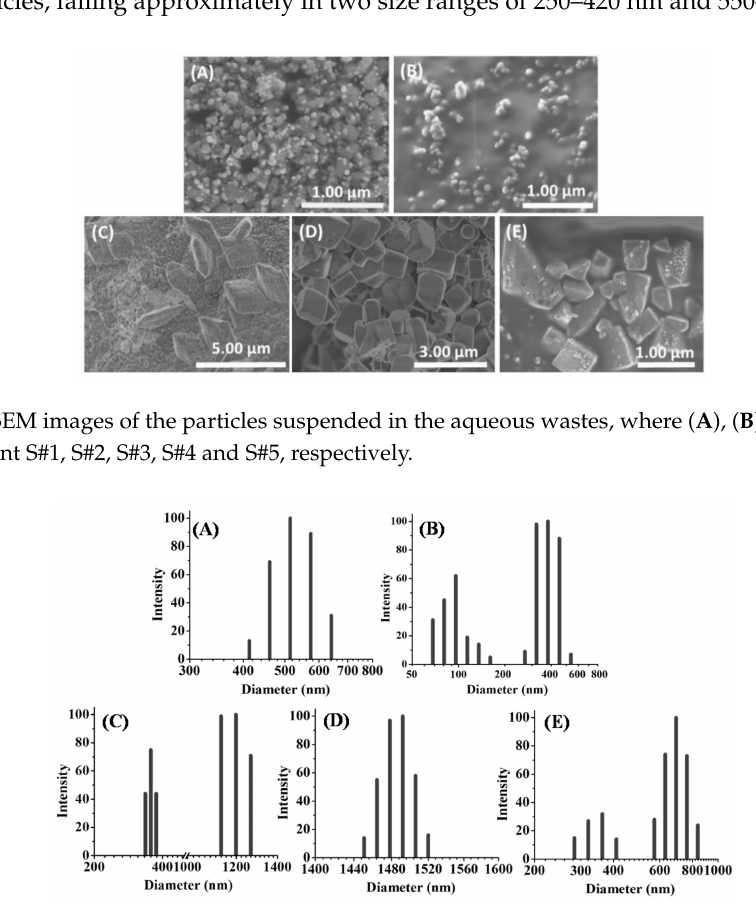
Figure 6. Size distribution of the particles suspended in the aqueous wastes, where ( A ), ( B ), ( C ), ( D ) and ( E ) represent S#1, S#2, S#3, S#4 and S#5,